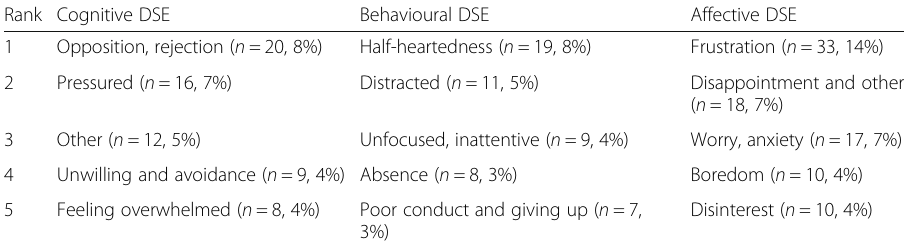
Table 4 Top five disengagement indicators Rank Cognitive DSE